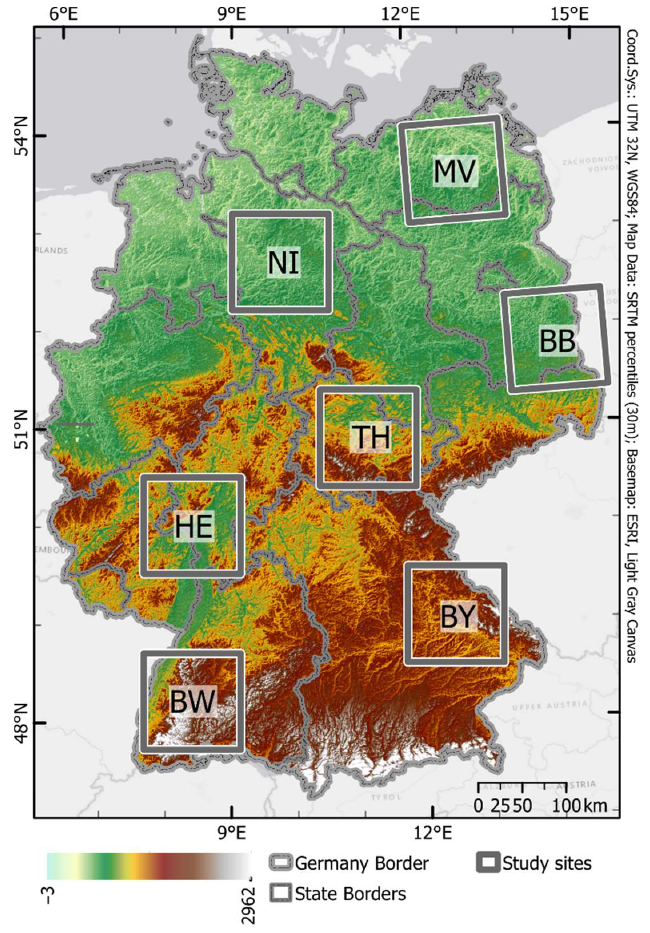
Figure 1. Location of the seven study sites in Germany. According to the present Köeppen-Geiger climate classification [23], the western three tiles (NI, HE, and BW) are located in class Cfb, which is characterised by a temperate oceanic climate with warm summers and no dry season. A warm-summer continental cli- mate defines the eastern four tiles (TH, BY, MV, and BB) with no dry seasons (class Dfb). During the summer months of 2018, the lowest and the highest monthly mean air temper- atures were recorded in tiles BY and BB [24]. The precipitation pattern varied over the year in all tiles [25]. The outstanding peaks of the monthly total precipitation occurred in tile BW (Figure 2). In general, the year 2018 was recorded as the warmest and sunniest year in Germany since at least 1881 [26], with the longest heat periods in July and August. This led to substantial negative anomalies in remotely sensed vegetation activity on agri- cultural land [27] and substantial yield losses [28]. However, the spatial patterns of anom- alies recorded in 2018 were different across the country. It was a good study case for the assessment of the spatial transferability of Random Forest models under varying environ- mental and climatic conditions at the country scale.